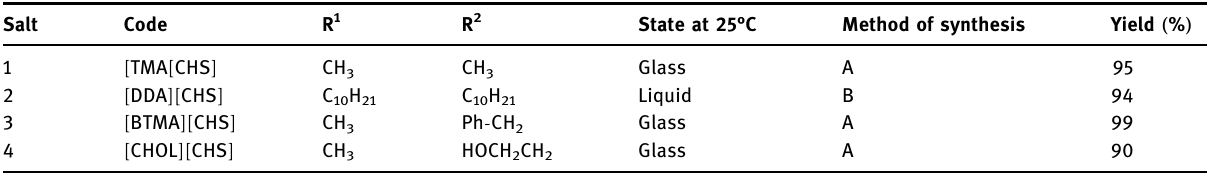
Table 1: Obtained chlorsulfuron - based salts ( 1 – 4 )